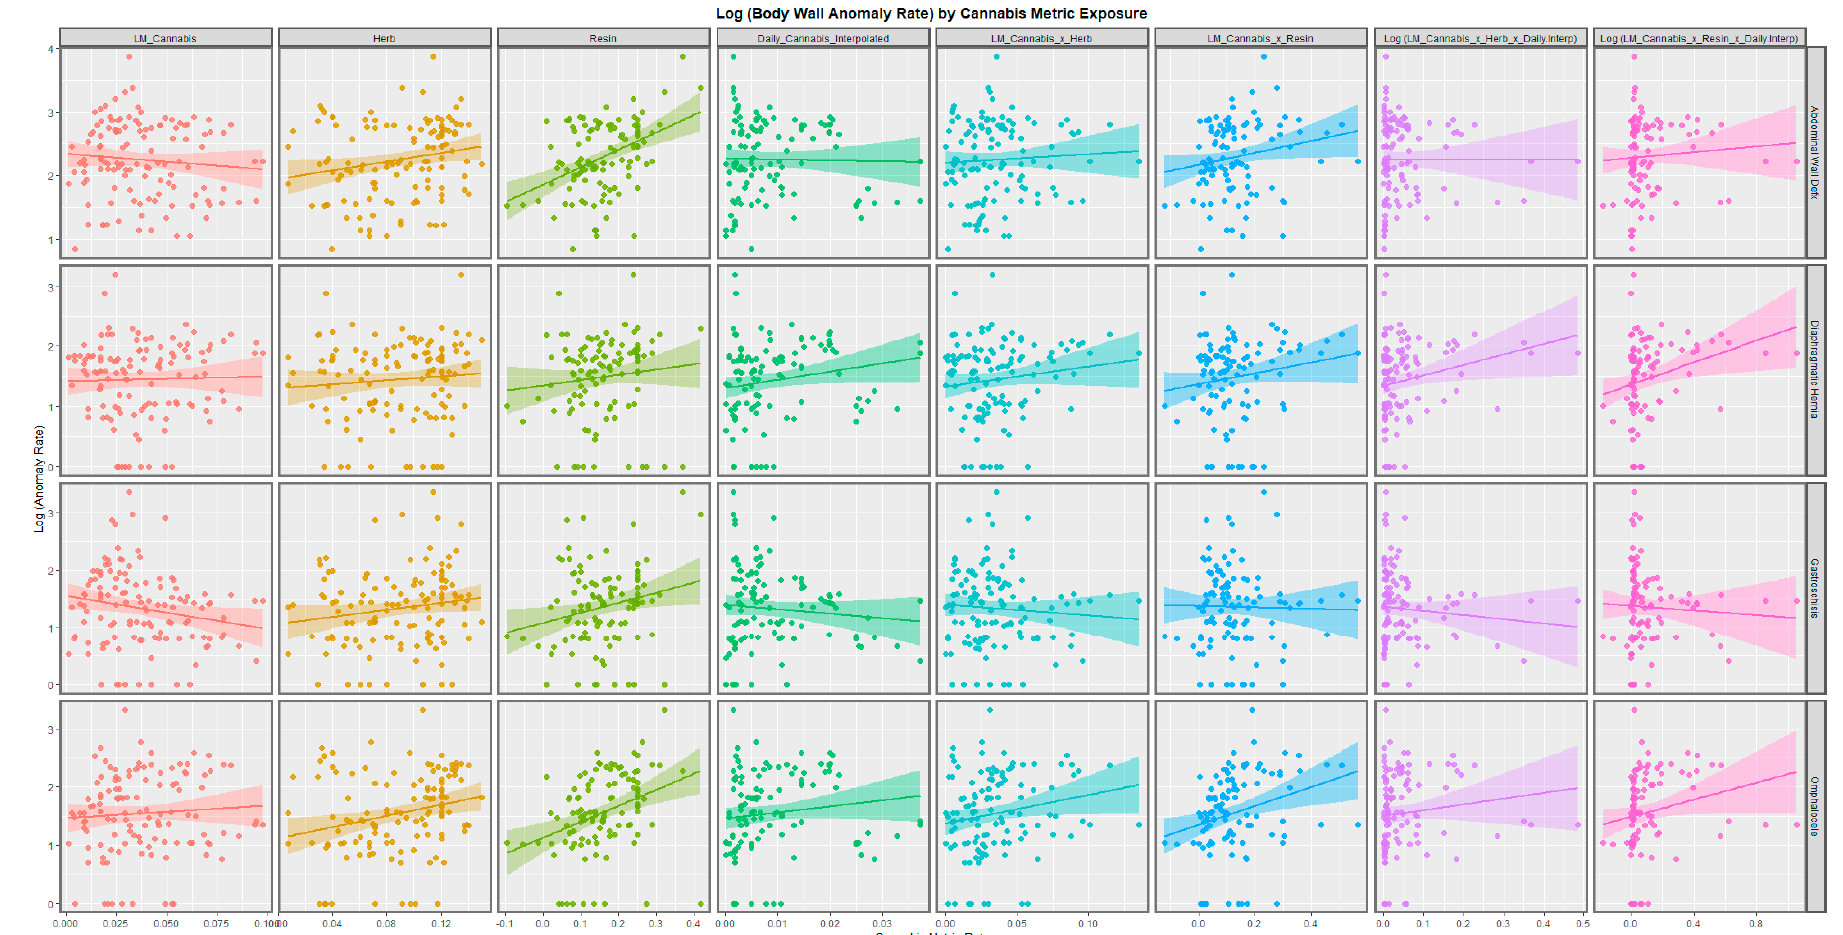
Figure 2. Paneled scatterplots of body wall anomalies by anomaly and by cannabis metric.